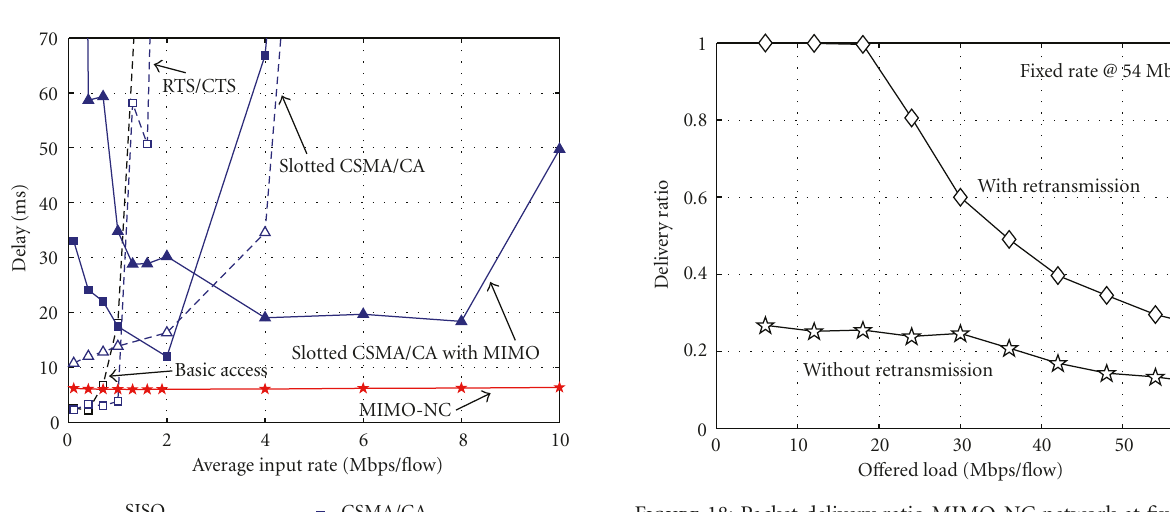
Figure 18: Packet delivery ratio MIMO-NC network at fixed data rate of 54